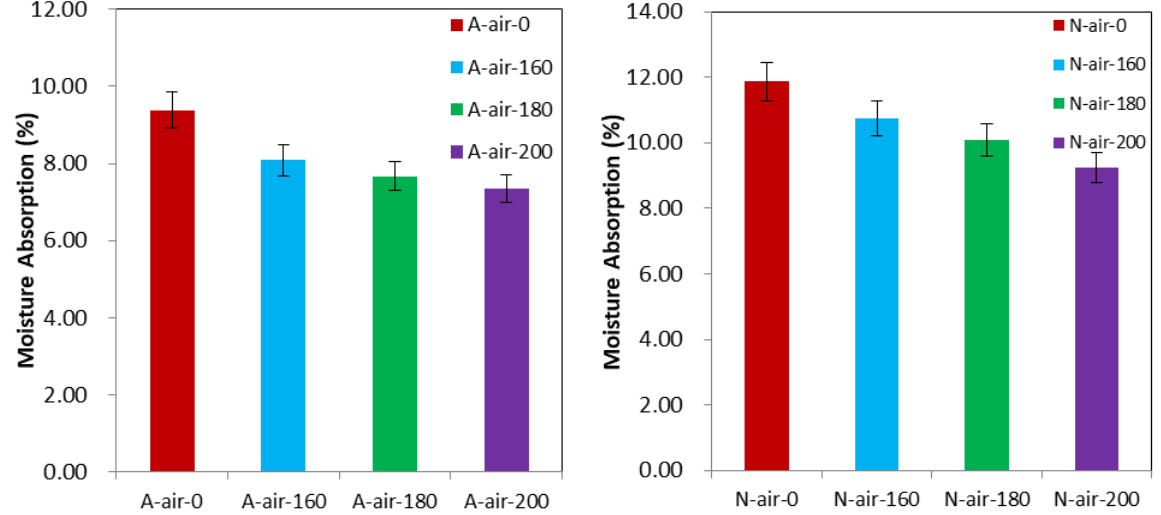
Figure 6. Moisture absorption of Afrormosia and Newtonia heat treated under air.